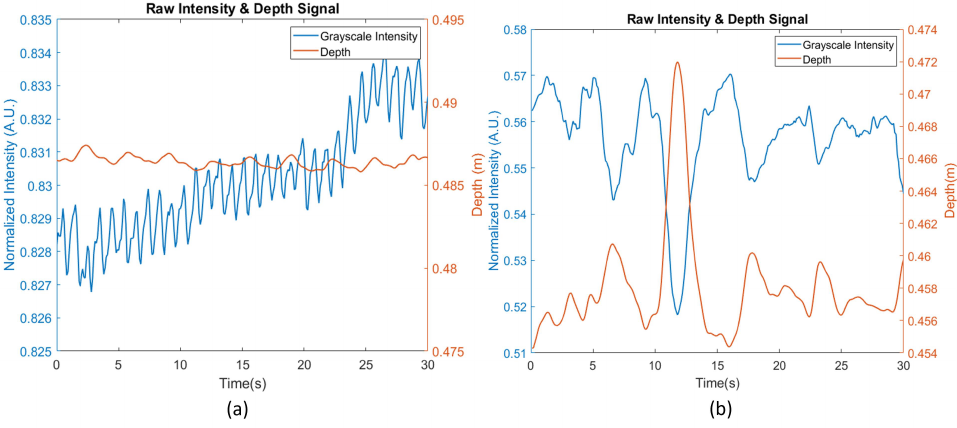
Figure 5. ( a ) Raw intensity signal (blue) and depth signal (red) from ROI-1 when participants are intentionally staying still. The grayscale intensity shows a clear HR signal. ( b ) Raw intensity signal (blue) and depth signal(red) from ROI-1 when motion artifact is present. The grayscale intensity is dominated by motion induced intensity